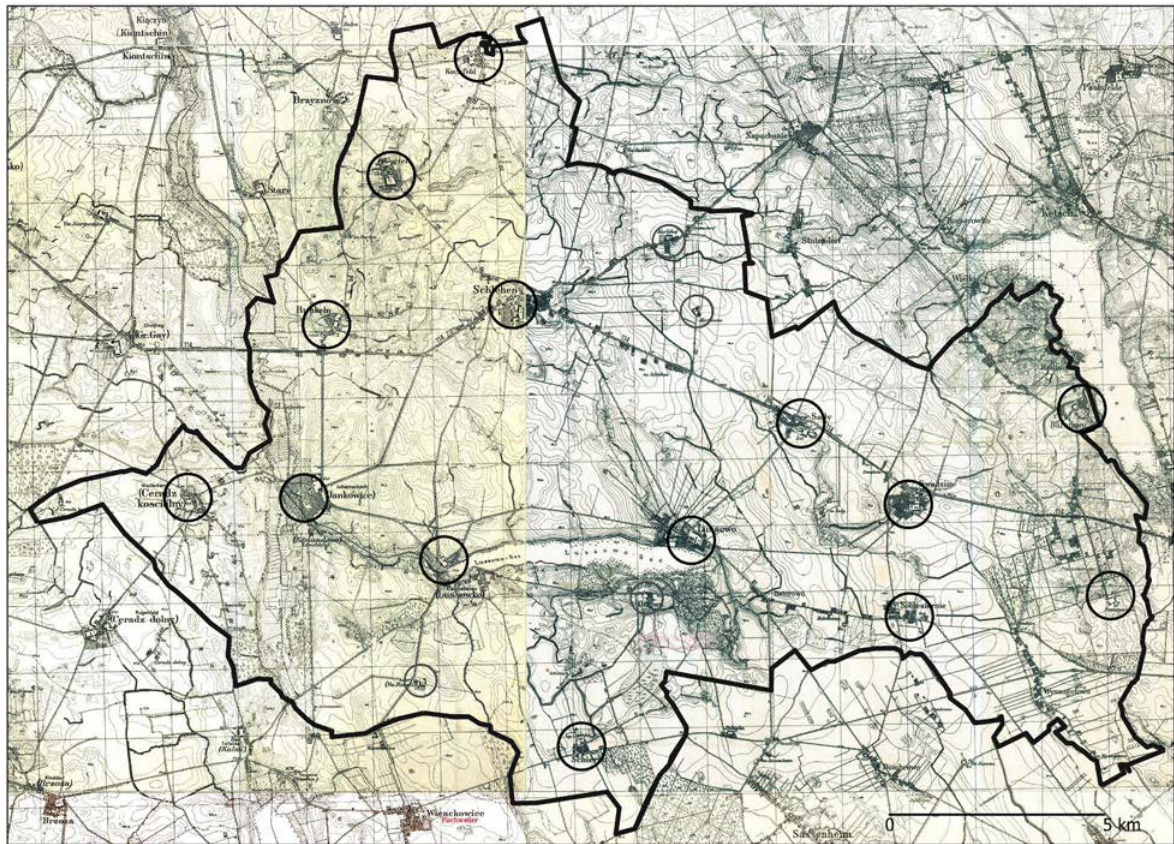
Fig. 4. Historical topographic map of the present-day Tarnowo Podgórne commune, published in the 1940s. Large circles mark the manorial and grange complexes listed in the Land Use Plan. Small circles mark the complexes not listed in the Plan. Source: own compilation based on